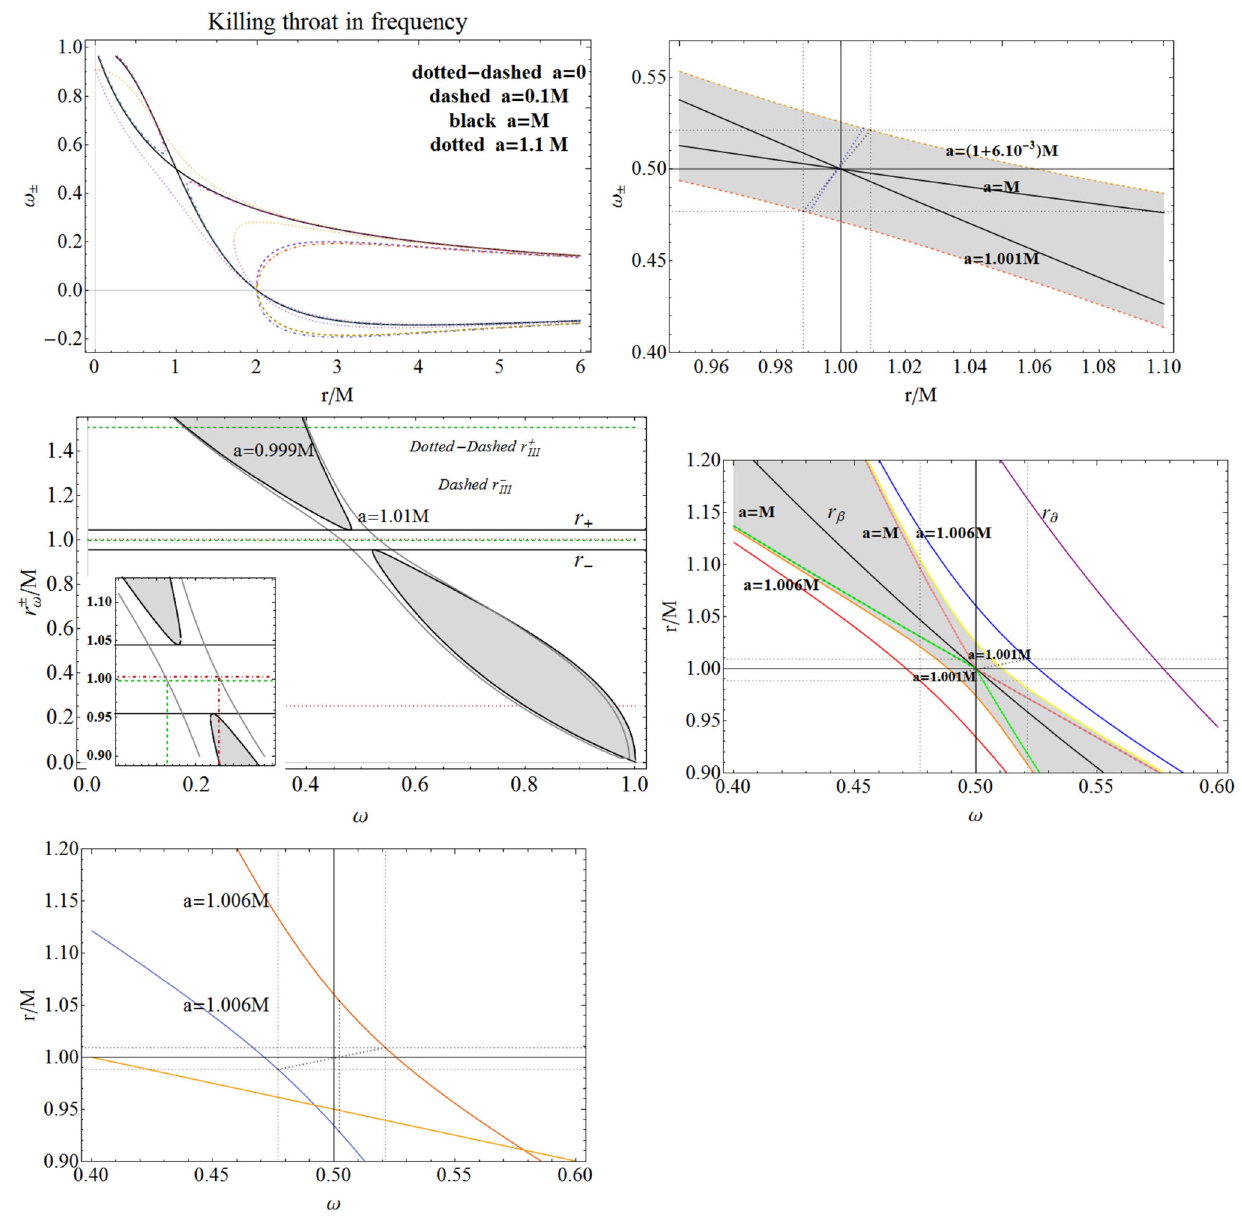
Fig. 2 Equatorial plane of the Kerr spacetime. Killing throat: zoom of the Killing bottleneck. Upper panels: the plane ω - r / M with plots of ω ± for different spins a / M . Left upper panel: light surfaces for different BHs to NSs . As a / M changes for weak naked singularities, the nar- rowing of the light surfaces is shown explicitly. Right upper panel: light surfaces in the bottleneck and the corresponding relevant radii. Bottom